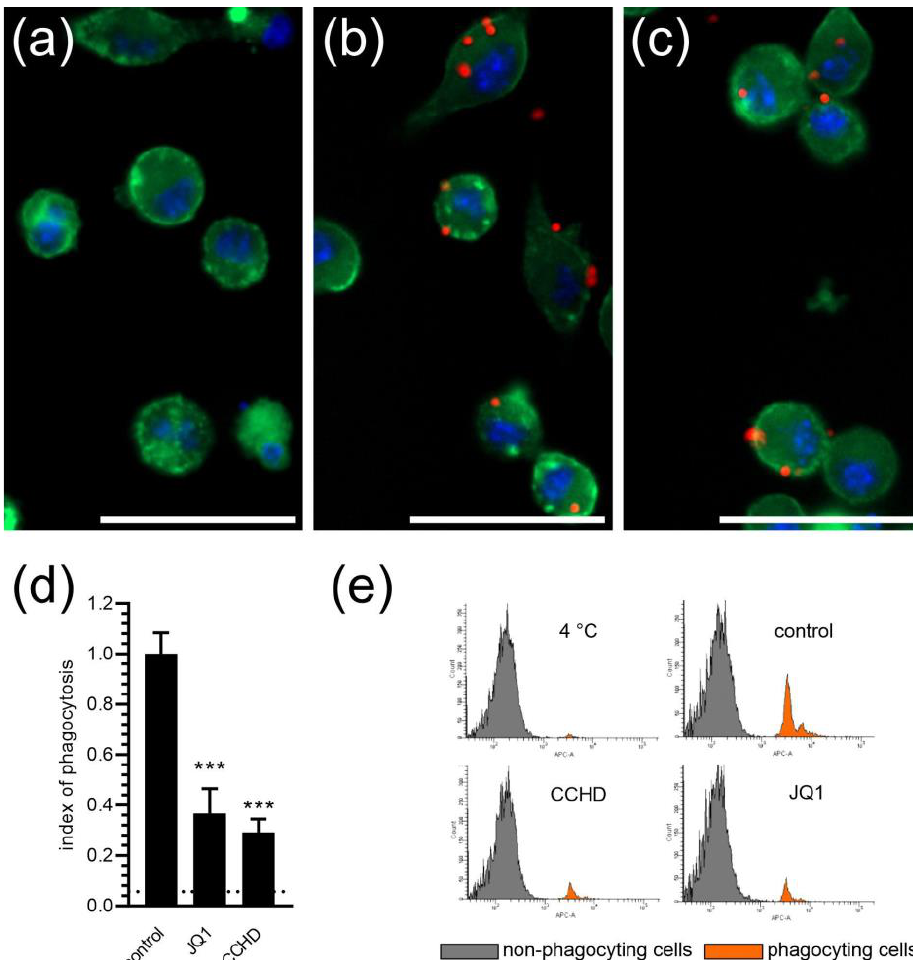
Figure 2. The effect of the BET inhibitor on phagocytosis of fluorescent microspheres by microglia. BV2 cells were incubated for 2 h without FMS ( a ), with FMS in the absence of JQ1 ( b ) or after 24 h of preincubation with 50 nM JQ1 ( c ). Cells are stained with green cytoplasmic dye and blue nuclear dye. Fluorescent microspheres are orange. The scale bar: 50 µ m. ( d ) Flow cytometric analysis of the effect of BET inhibitor and CCHD on FMS’ phagocytosis by microglia. The level of non-specific labelling is shown with a dotted line. ( e ) Typical flow-cytometric histograms of non-phagocytic and phagocyting BV2 cells. Means ± SEM are presented. n = 11–13; *** p < 0.001, compared to the control. Statistical analysis was performed by using a one-way ANOVA followed by the Bonferroni post hoc test.